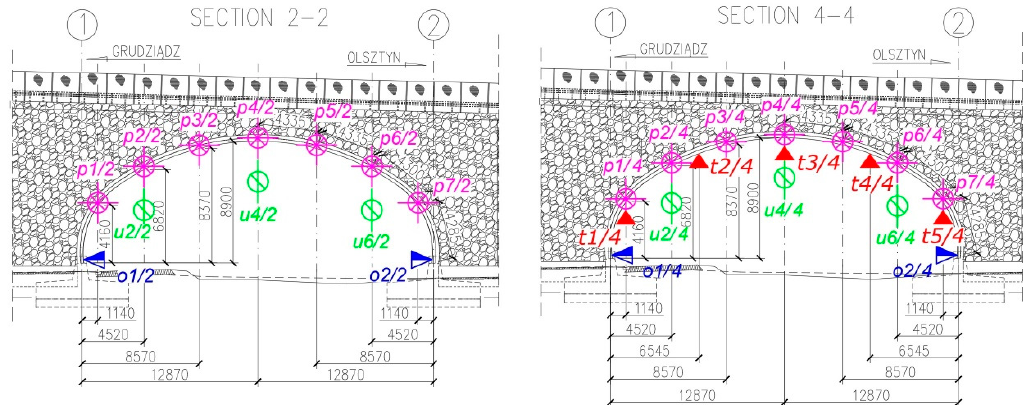
Figure 6. Location of the network of sensor used to collect the data during the static tests. sections 2-2 and 4-4 (dimensions in (mm)).